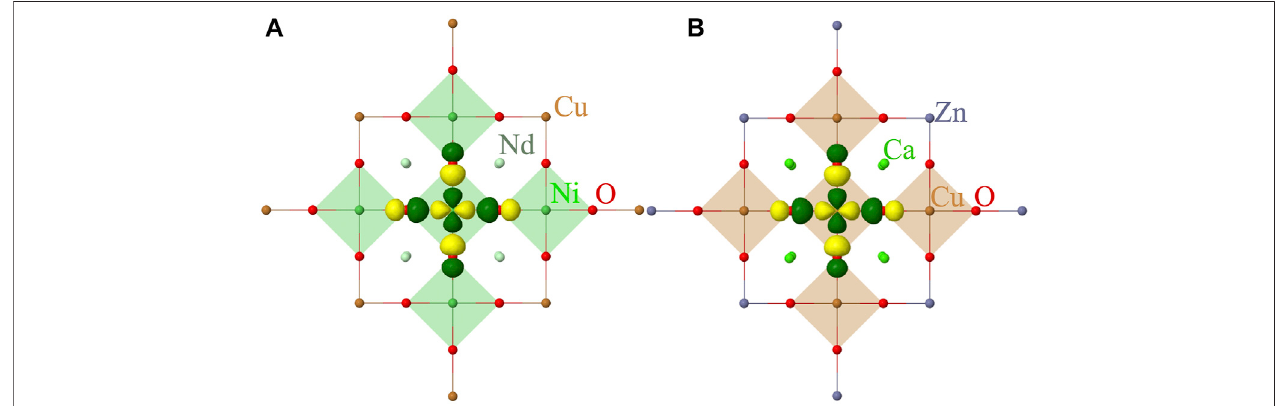
FIGURE 1 | Quantum cluster of fi ve NiO 4 (A) and CuO 4 (B) plaques considered in our calculations. The point-charge embedding is not shown. The symmetry adapted localized 3 d